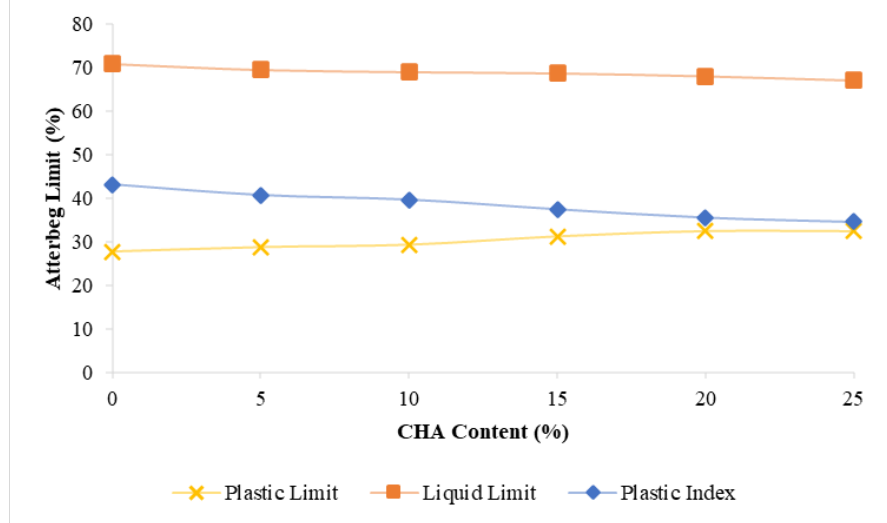
Figure 4. Atterberg limit of the clay – CHA mixture.